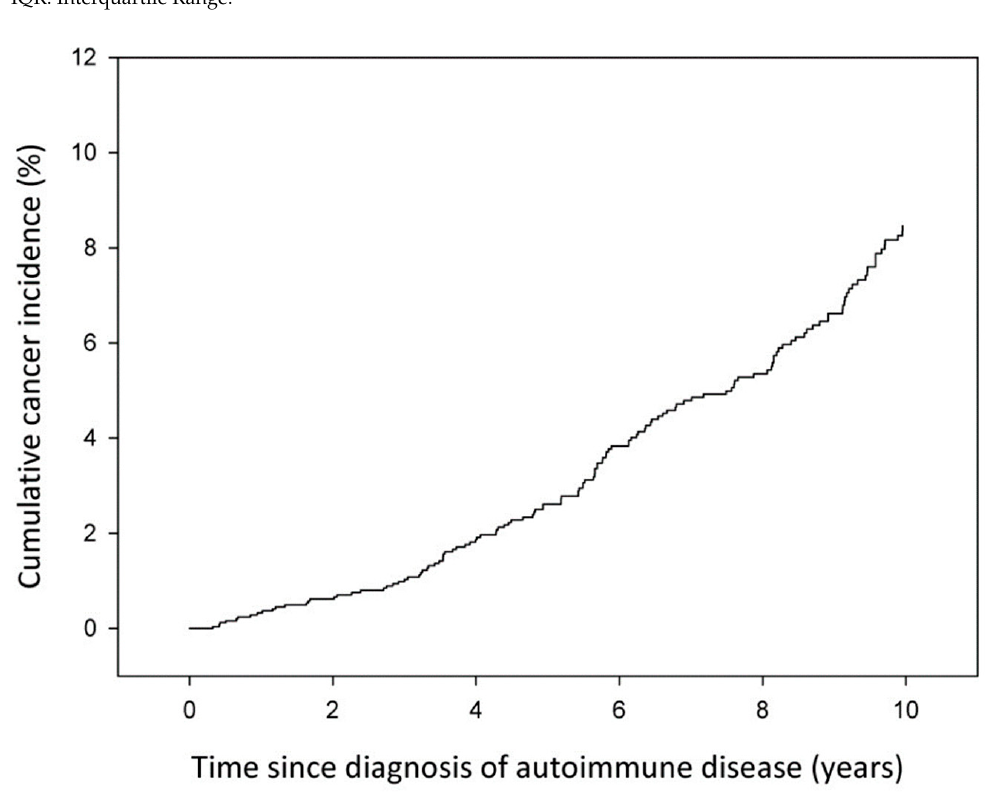
Figure 1. Cumulative cancer incidence by time since diagnosis of autoimmune disease. Friuli Venezia Giulia, 2002–2017. Cancers diagnosed within the first 90 days were excluded.